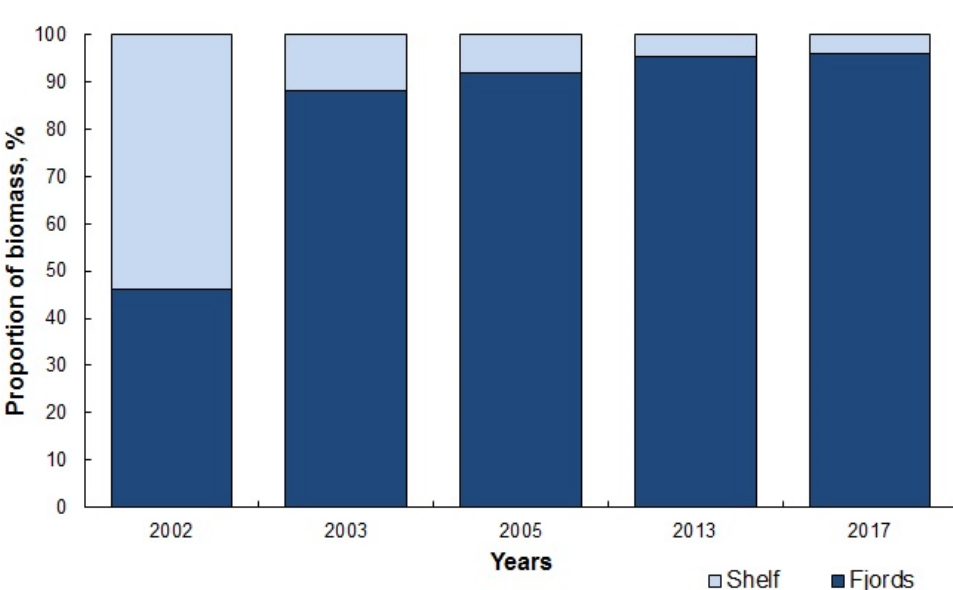
Figure 4. The proportional biomass of ice cod Arctogadus glacialis in fjords and on the shelf in Northeast Greenland. Total number of specimens N = 5442. Note, years 2007, 2010 and 2015 are excluded from comparisons because in these years stations were confined to either fjords or the shelf, cf. Table 1 and Figure 1.